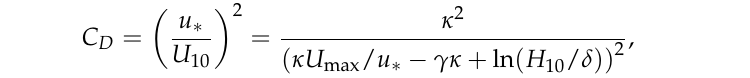
bias, RMSE, and Cor are − 0.3506, 4.8148, and 0.91, respectively. It can be seen that U 10 and U sfc are highly correlated. However, for speeds below 40 m/s, the values are somewhat underestimated, and for speeds above 40 m/s, they are overestimated.